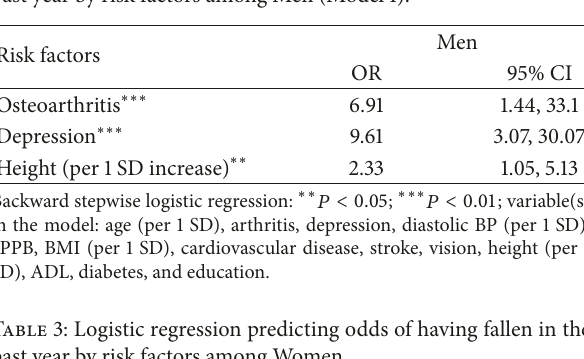
Table 2: Logistic regression predicting odds of having fallen in the past year by risk factors among Men (Model 1).